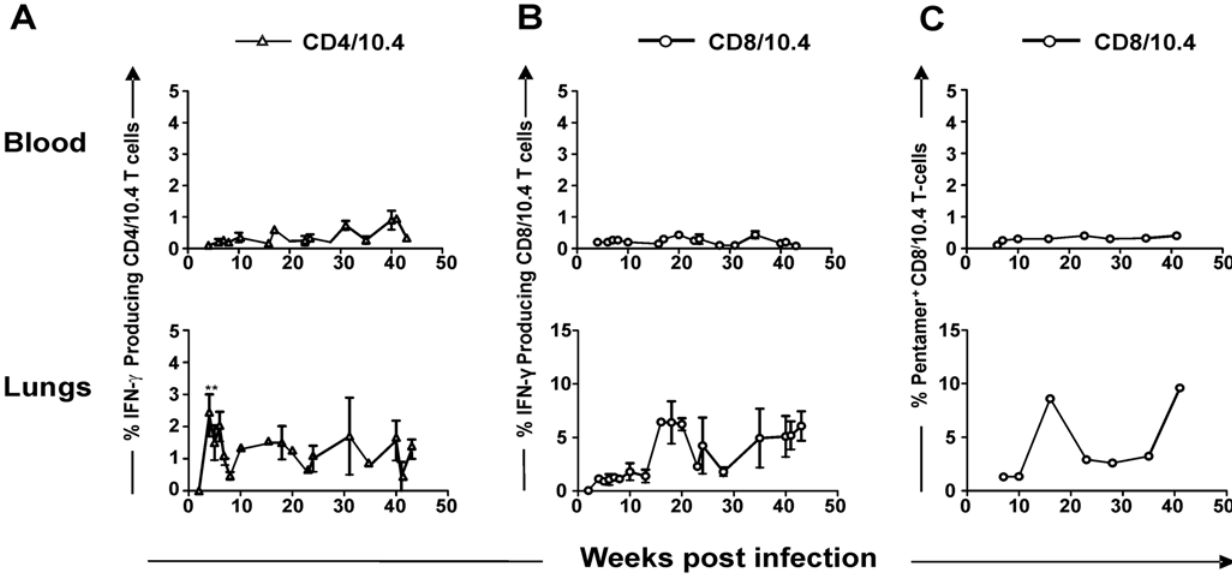
Figure 3. The kinetics of CD4/10.4 and CD8/10.4 following aerosol infection with M.tb . (A and B) CB6F1 mice were infected by the aerosol route with virulent M.tb Erdman and lymphocytes were obtained from lungs or blood and then stimulated with TB10.4 3–11 or TB10.4 74–88 for assessment of IFN- c production by FACS analysis. Frequencies represent IFN- c production out of total T cells. Background staining from cells stimulated with medium alone has been deducted (Background , 0.5%). Each time point represents the mean from at least three individual mice 6 standard error of the mean (SEM). (C) Lung or blood cells were stained directly ex vivo with H2- K b pentamer loaded with IMYNYPAM. Background staining from naı¨ve mice has been deducted. Each time point consists of data from a pool of 3–6 mice. (**p , 0.01, Student’s